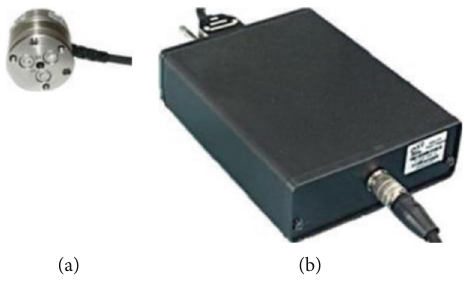
Figure 4: Sensor (a) and signal conditioning box (b).